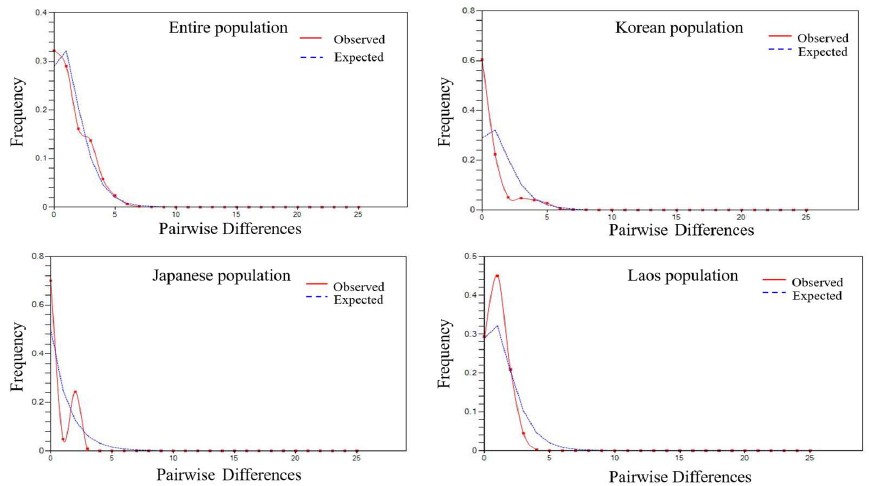
Figure 3. The observed pairwise mismatch distribution of mitochondrial DNA in Aedes albopictus as compared with the expected distribution based upon a model of population expansion. The model of population expansion was calculated using DnaSP software.